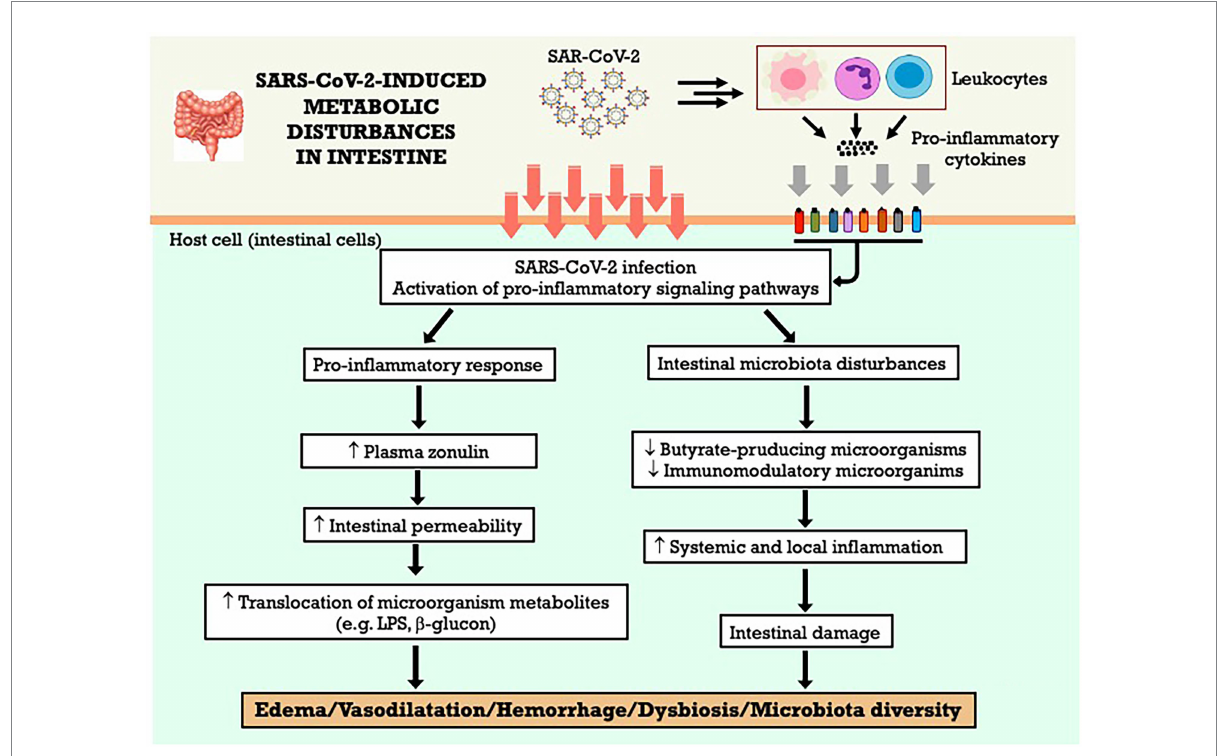
FIGURE 6 SARS-CoV-2-induced metabolic disturbances in gastrointestinal system. LPS,